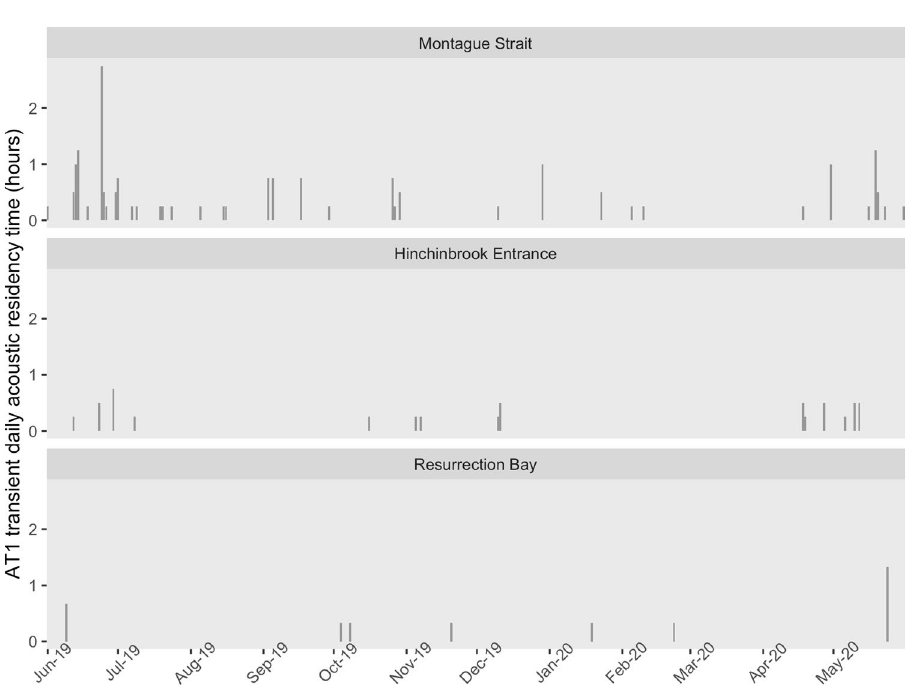
Figure 5. Hours per day with AT1 transient killer whale detections at Montague Strait, Hinchinbrook Entrance, and Resurrection Bay, Gulf of Alaska, June 2019 to May